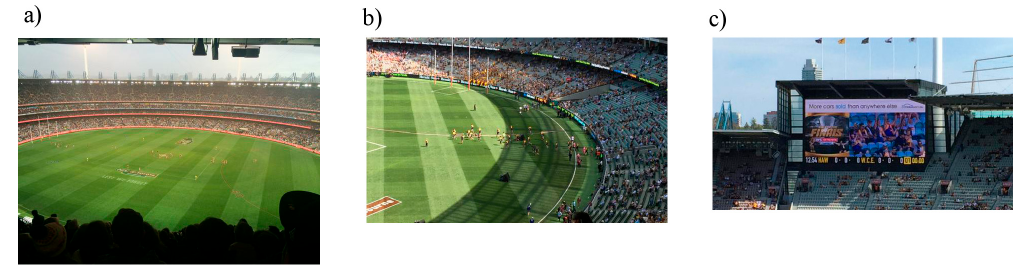
Figure 7. Images ( a ) [67] ( b ) [68] and ( c ) [69] are examples of images categorized as WA OTG with geotag locations outside the event venue.